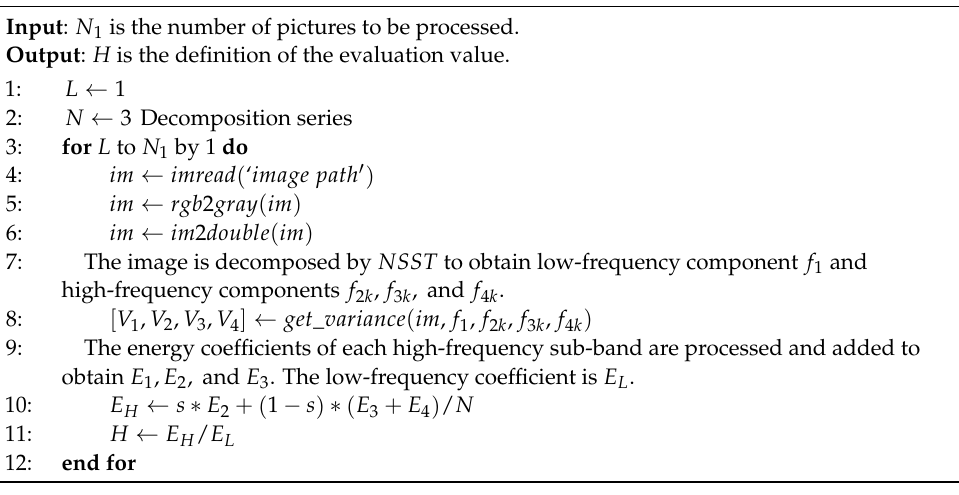
Algorithm 1. Pseudo-Code of the Algorithm